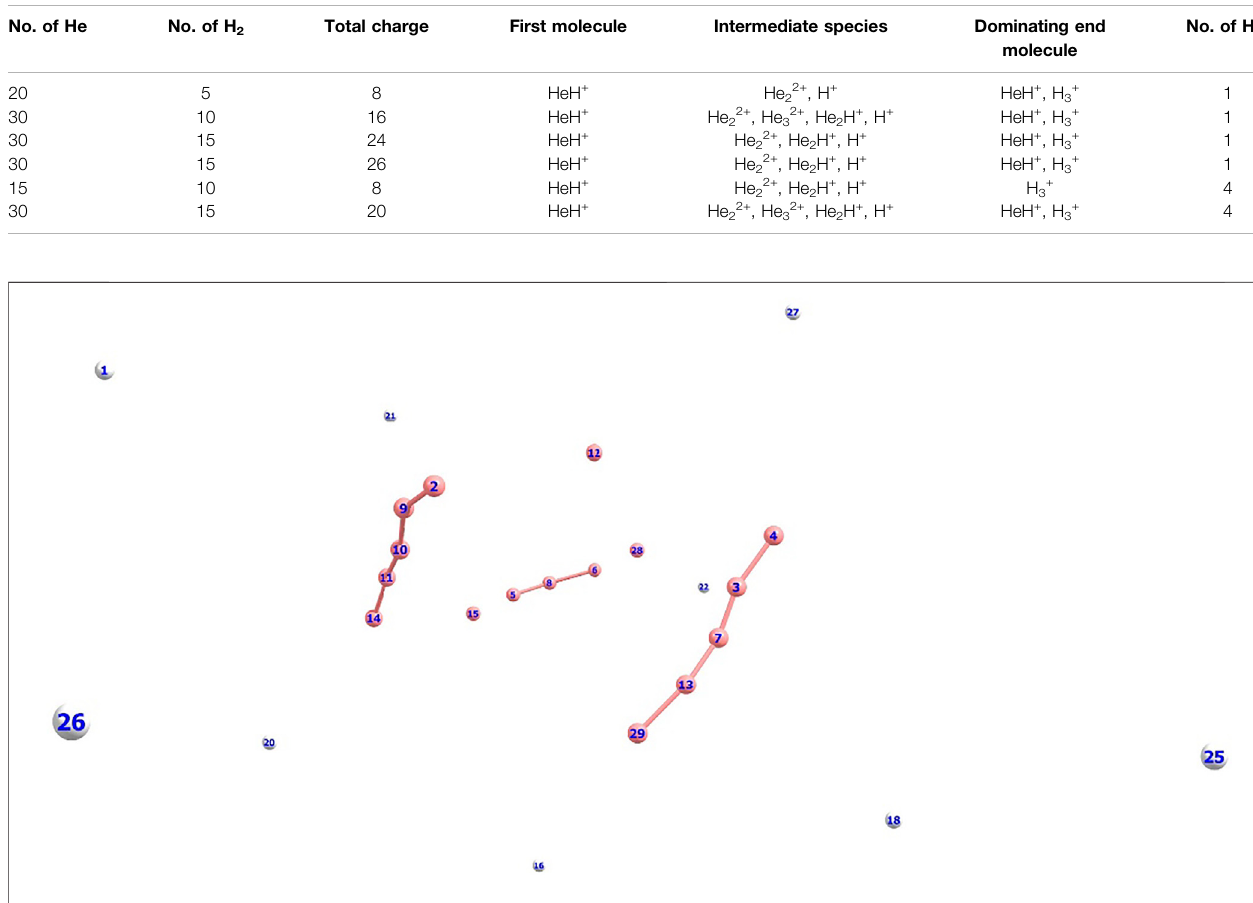
Frontiers in Chemistry |